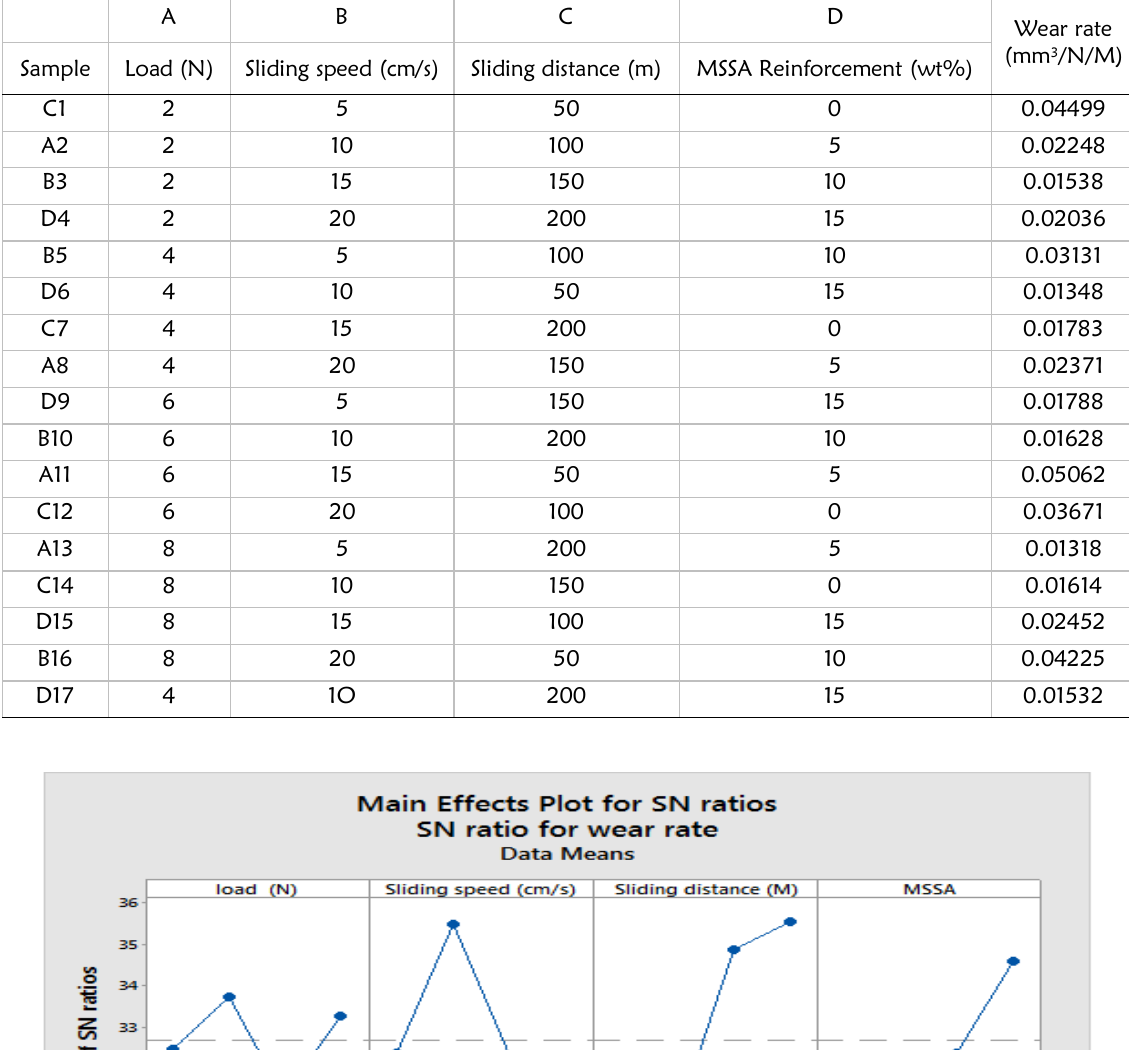
Table 3: Evaluation of the impute process parameters based on based on Taguchi L16 design